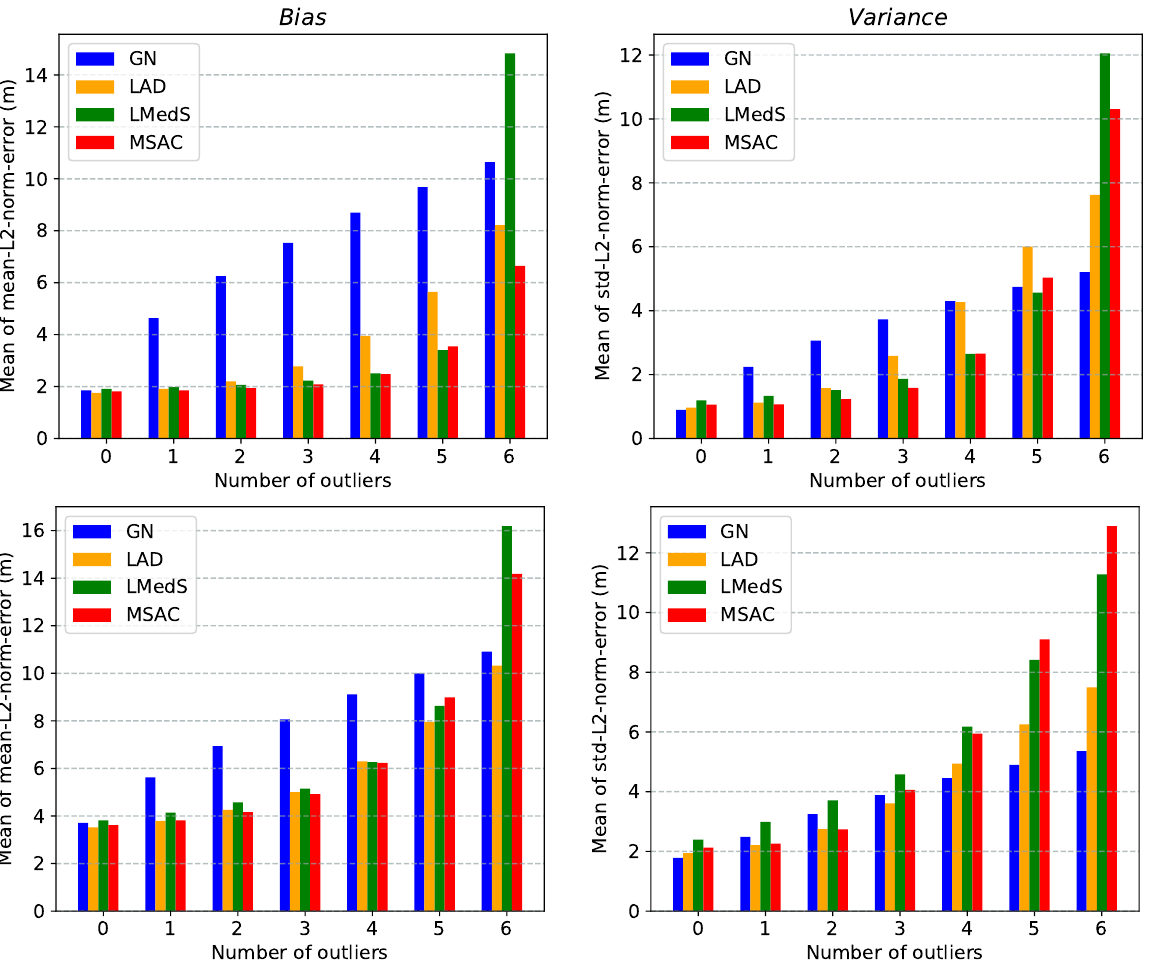
Figure 8. Simulation results for i.i.d. Exponential noise in the ToA measurements. First column shows bias , and second column shows variance . The first and second row shows the results when the inlier ToA measurements have Exponential noise with scales σ = 1.0 ms and σ = 2.0 ms, respectively. The outliers are created by adding random values from